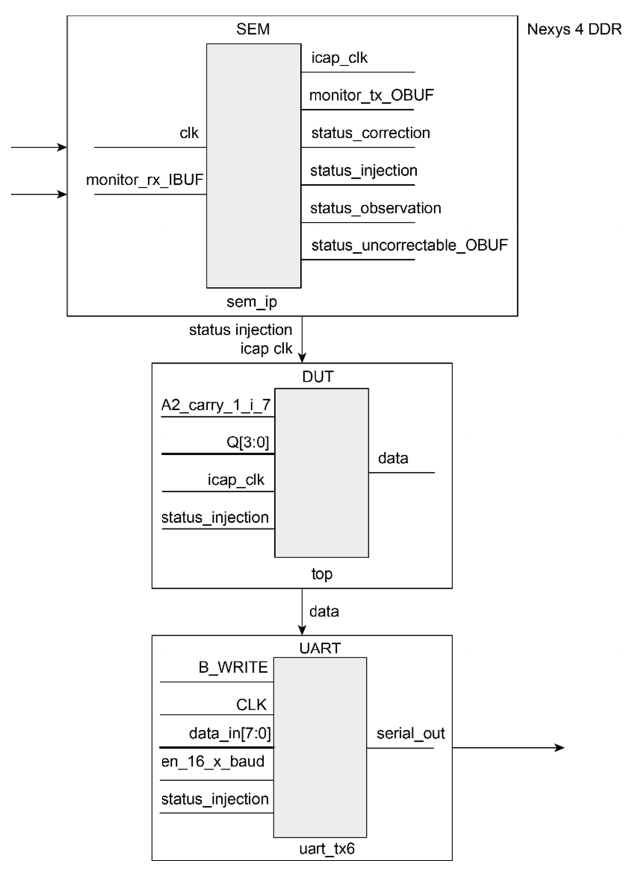
Figure 9. Source files overview.